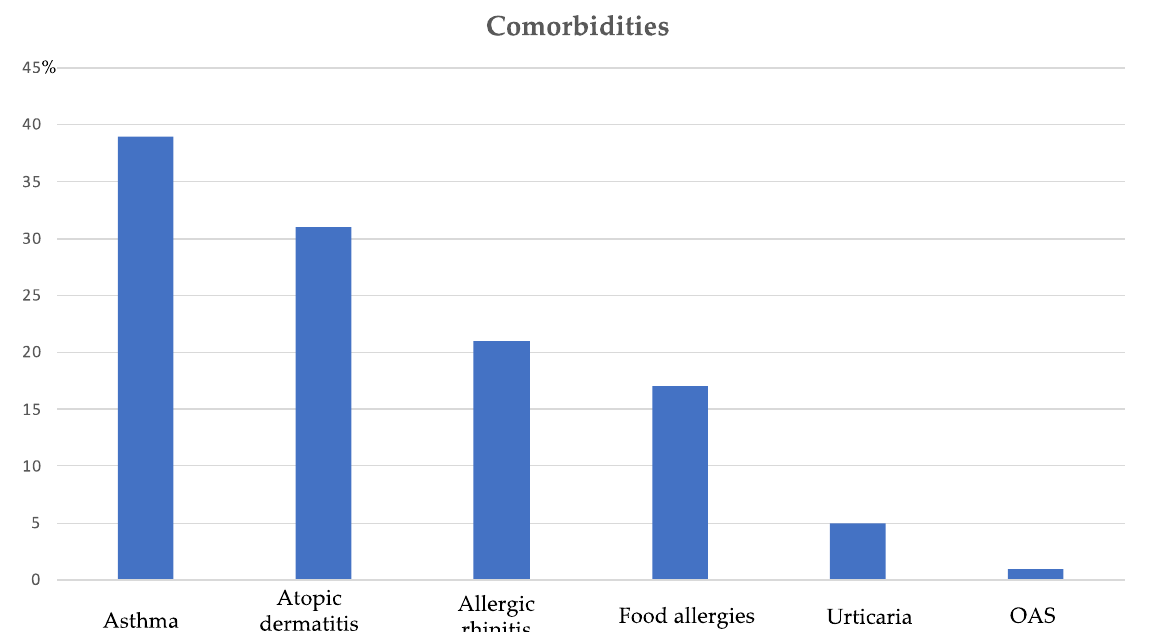
Table 1. Laboratory data before oral food